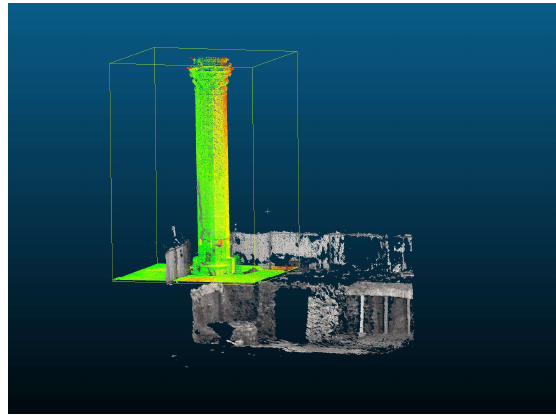
Figure 9 . Photogrammetry point cloud (greyscale) scaled to match the reference LIDAR point cloud (gradient).